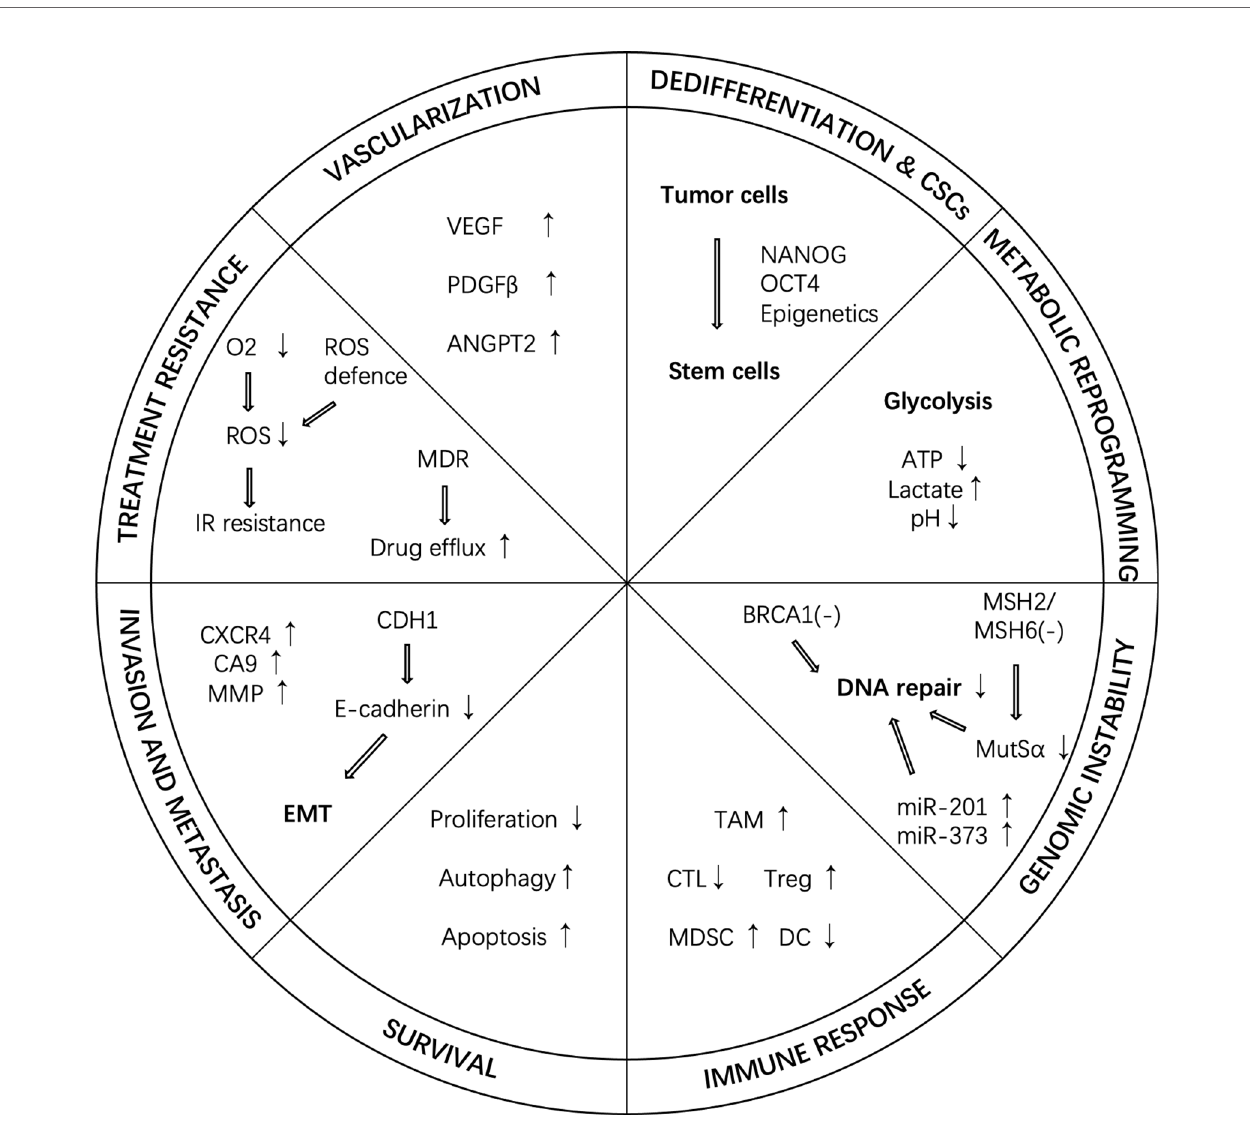
FIGURE 2 | Cancer hallmarks regulated by HIF under hypoxic conditions. In hypoxic conditions, HIF can regulate a variety of cancer phenotypes, such as vascularization, dedifferentiation, metabolic reprogramming, genome instability, immune response, survival, invasion and metastasis, and treatment resistance. ANGPT2, angiopoietin 2; CTL, cytotoxic T-lymphocyte; CSC, cancer stem cell; DC, dendritic cell; IR, ionizing radiation; MDR, multi-drug resistance; MDSC, myeloid- derived suppressor cell; PDGF- b , platelet-derived growth factor- b ; ROS, reactive oxygen species; TAM, tumor-associated macrophage; Treg, regulatory T-cell; VEGF, vascular endothelial growth